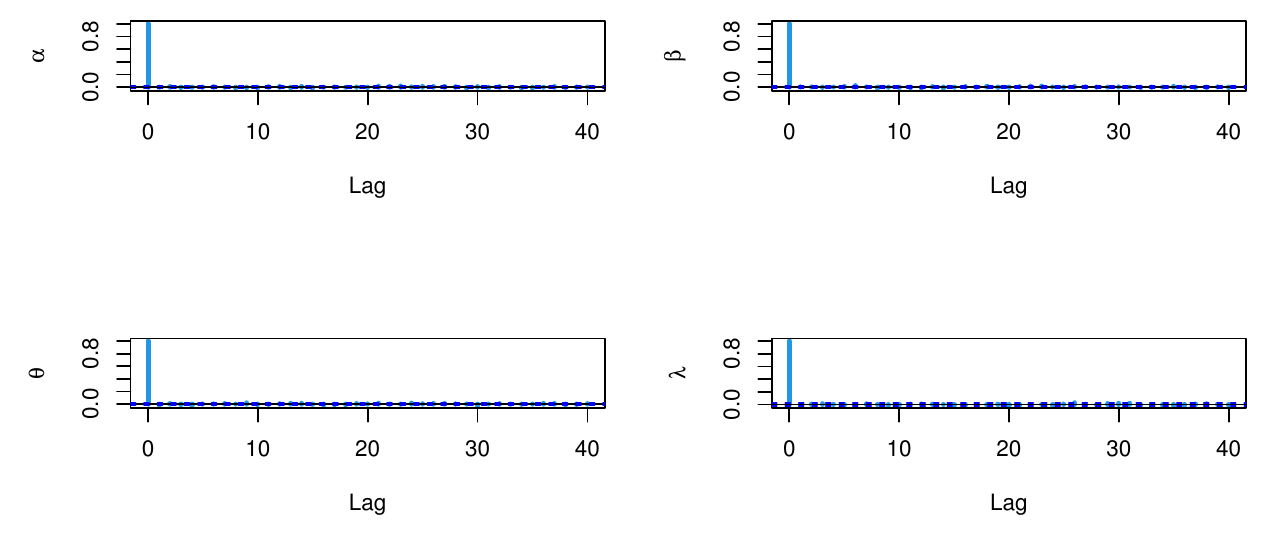
Figure 28. ACF test plots for parameters of TLMW model for single carbon